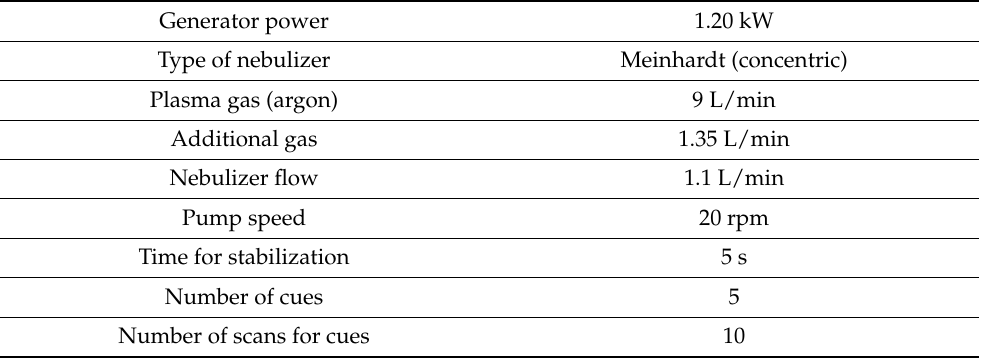
Table 3. Instrumental parameters for ICP-MS measurements.